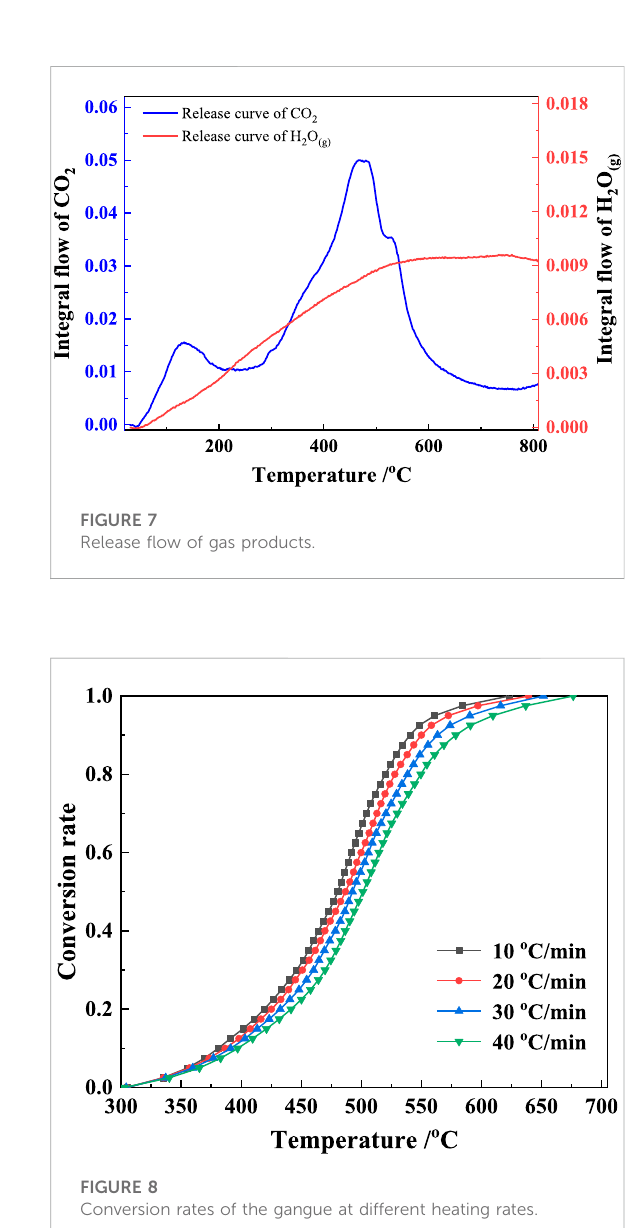
FIGURE 8 Conversion rates of the gangue at different heating